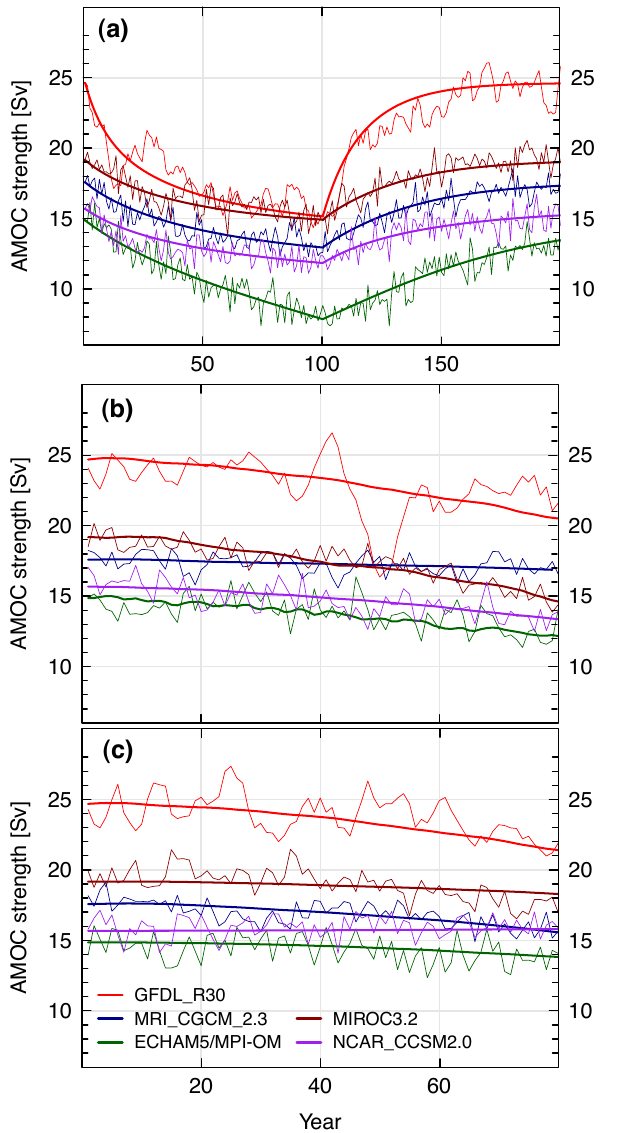
Fig. 2. The results of the calibration procedure, the thin line rep- resents the AOGCM output, the thick line the best fit results of our emulation. (a) The freshwater hosing experiment by Stouffer et al. (2006), where 0.1Sv are artificial added in the Northern North At- lantic for 100 years starting in year 1. (b) The transient change in the AMOC strength as presented in Gregory et al. (2005) for a sce- nario with a compounded 1% per year increase in the CO 2 concen- tration, while the freshwater fluxes are kept constant. (c) The same scenario as in (b) , but with constant CO 2 -concentrations, whereas the freshwater fluxes of the full transient scenario are applied.